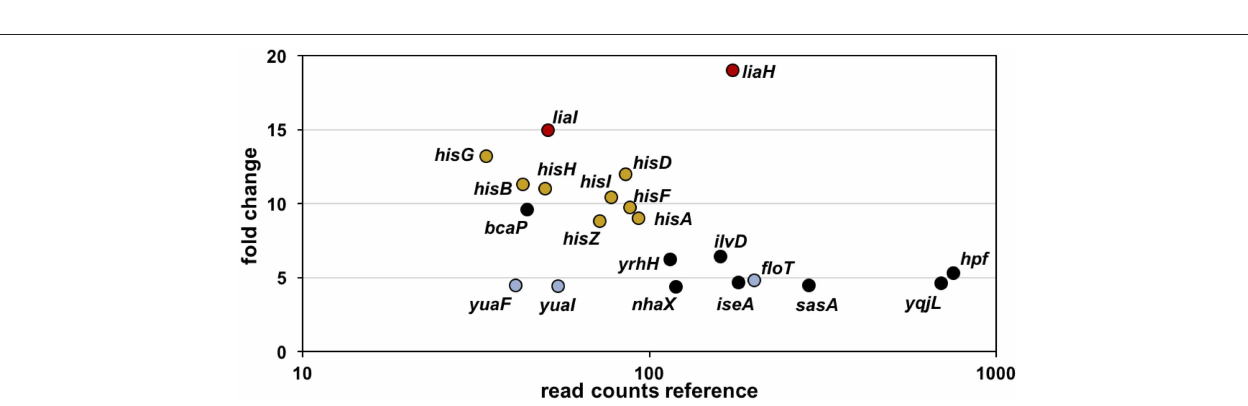
FIGURE 2 | Growth curves and luciferase activity of B. subtilis P liaI - lux strains. Upper panels depict growth curves, lower panels show luminescence values normalized over optical density. (A) Growth in minimal media of P liaI - lux strains in the wild type background and individual yyd mutants. (B) Wild type P liaI - lux (red) and an empty vector control (blue) incubated in full medium, were challenged with extrinsic added 0.5 µ M YydF* (full lines) or non-treated (dotted lines).